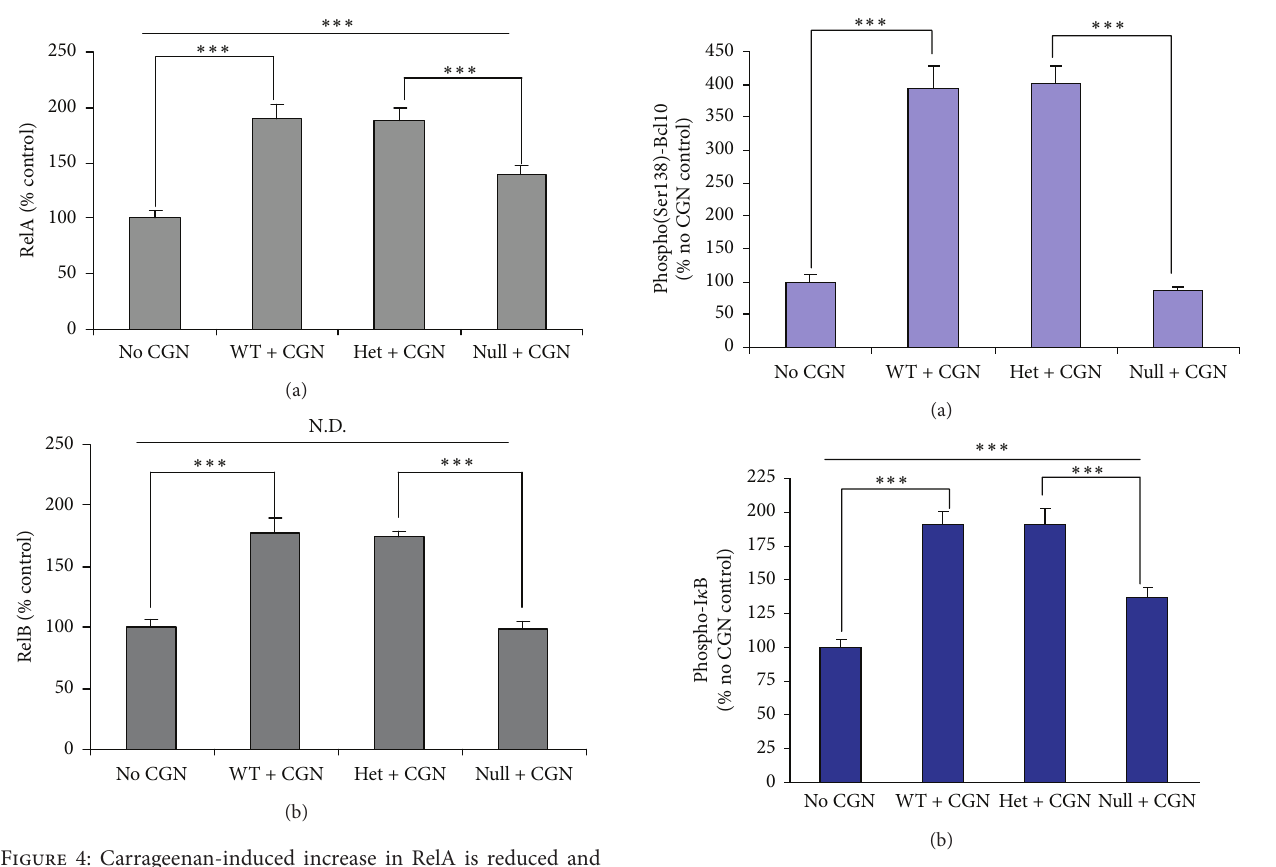
Figure 5: Phosphorylation of Bcl10 is absent and of I 𝜅 B 𝛼 is reduced inBcl10nullmicefollowingcarrageenan.(a)Phospho(Ser138)-Bcl10 was increased to ∼ 400% of the no carrageenan baseline when the Bcl10 wild type and heterozygous mice were exposed to carrageenan ( 𝑃 < 0.001 ) but not in the Bcl10 null mice. (b) The increase in phospho(Ser32)-I 𝜅 B 𝛼 is less in the Bcl10 null mice, compared to the wild type and heterozygous mice (increase of ∼ 37% versus ∼ 91%), but the increase from the baseline no carrageenan value is also significant ( 𝑃 < 0.001 ). CGN: carrageenan; WT: wild type; Het: